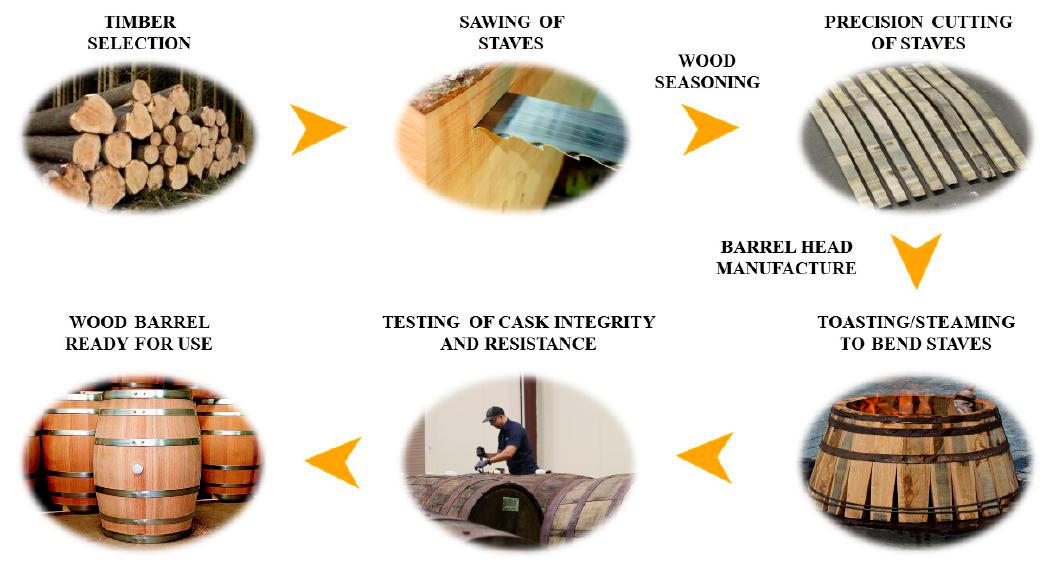
Figure 1. Barrel manufacturing process.